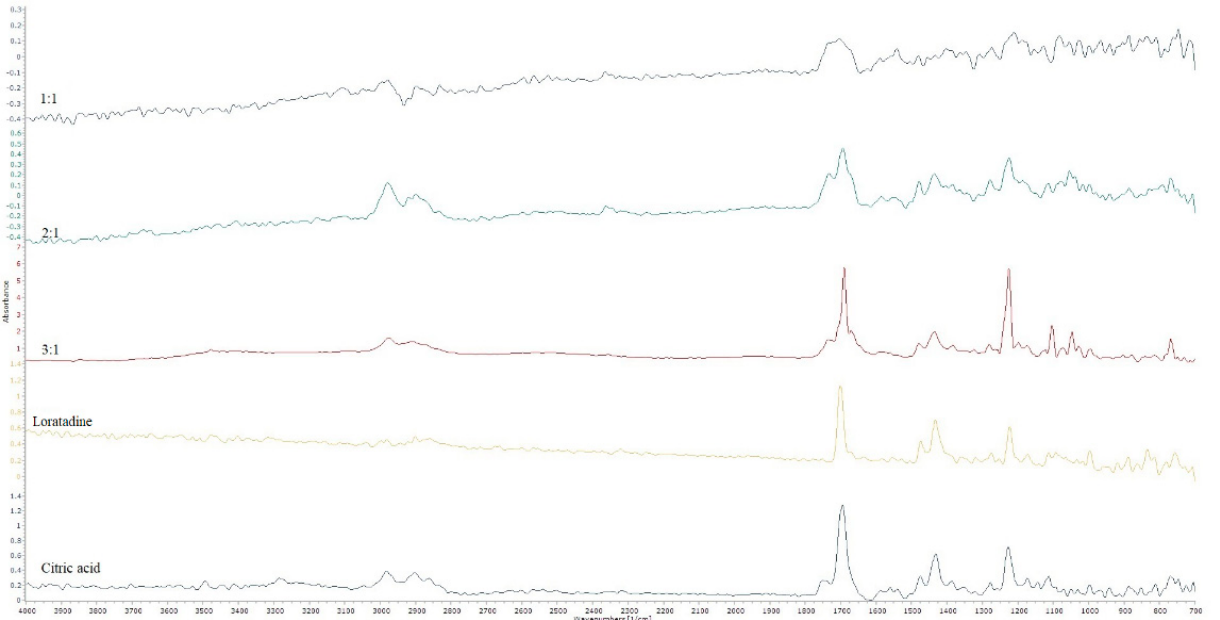
Figure 3. FTIR spectra of loratadine, citric acid, and binary mixtures 1:1, 2:1, 3:1 of loratadinecitric acid.